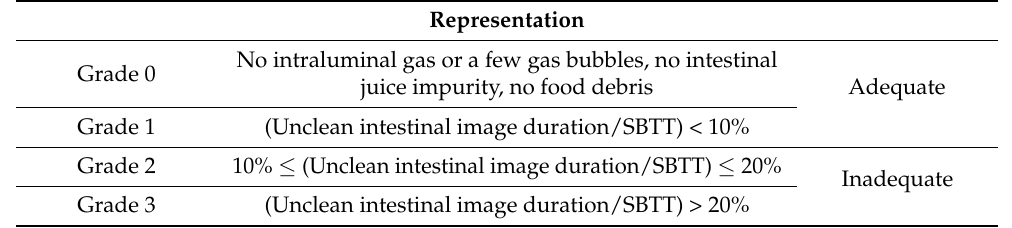
Table 1. Grading system of small bowel visibility quality. Representation No intraluminal gas or a few gas bubbles, no intestinal Grade 0 juice impurity, no food debris Adequate Grade 1 (Unclean intestinal image duration/SBTT) < 10% Grade 2 10% ≤ (Unclean intestinal image duration/SBTT) ≤ 20% Inadequate Grade 3 (Unclean intestinal image duration/SBTT) >